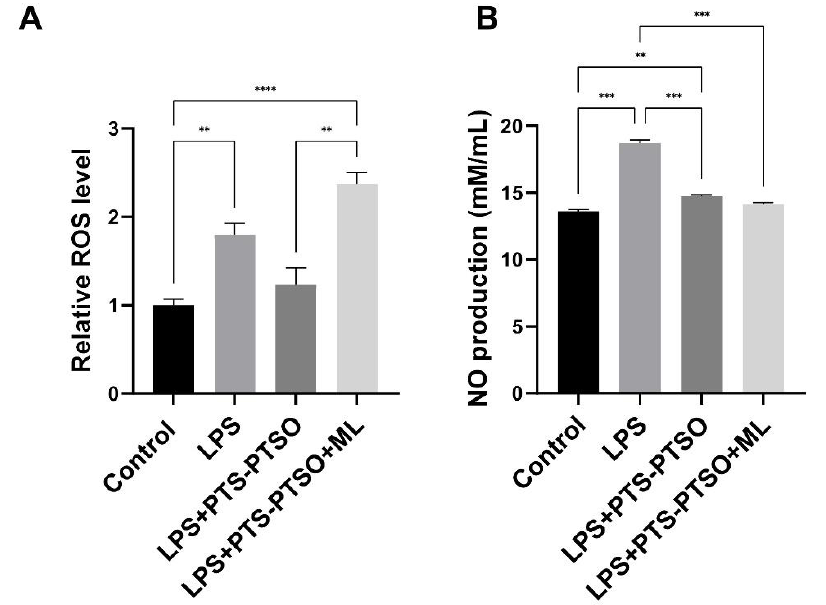
Figure 2. PTS-PTSO inhibits reactive oxygen species (ROS) production and nitric oxide (NO) release in murine macrophages. ( A ) ROS level in RAW264.7 cells stimulated with PTS-PTSO (20 µ M) + LPS or PTS-PTSO + LPS combined with Nrf2 inhibitor ML385 (5 µ M), n = 6 replicates per treatment. ( B ) NO production in RAW264.7 cells stimulated with PTS-PTSO (20 µ M) + LPS or PTS-PTSO + LPS combined with Nrf2 inhibitor ML385 (5 µ M), n = 4 replicates per treatment. Data bars represent mean ± SEM. ** p ≤ 0.01, *** p ≤ 0.001, **** p ≤ 0.001.